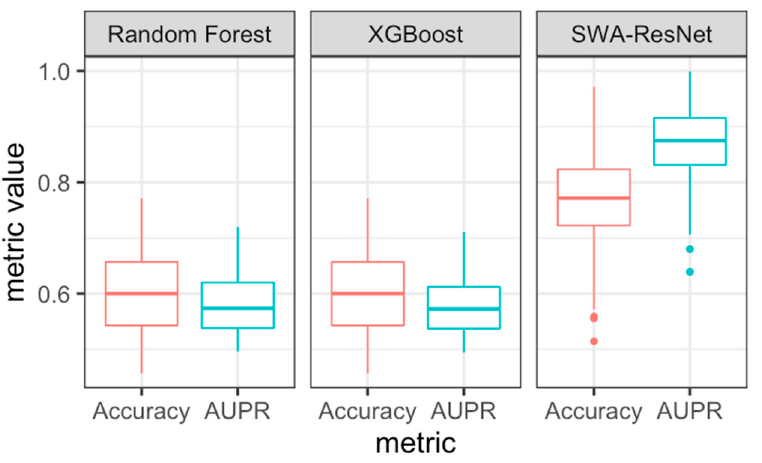
Figure 2. Comparison of accuracy (as a decimal, red boxplot) and area under the precision-recall curve (AUPR, blue boxplot) of classifiers on ResNet feature embeddings of ACP MRI.